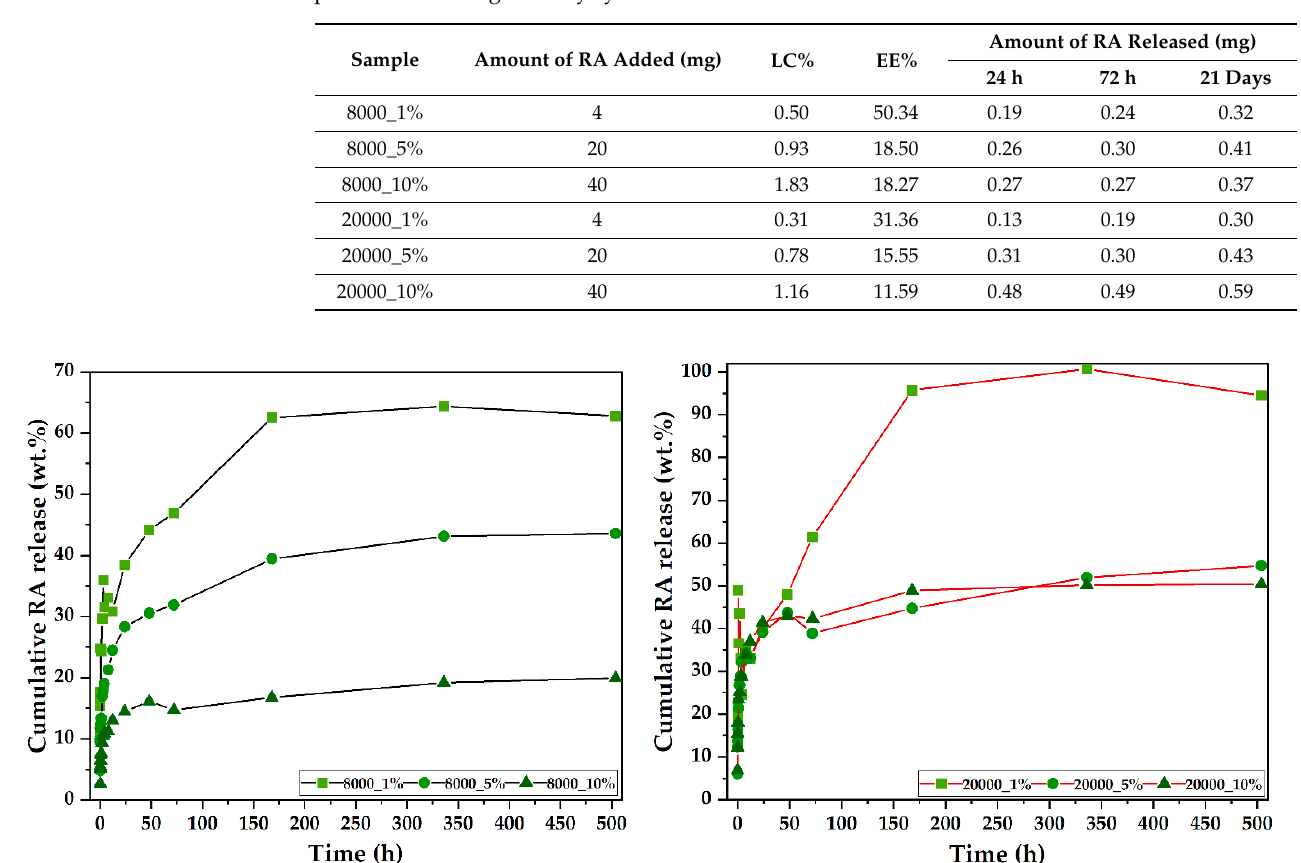
Figure 6. Hydrodynamic diameter ( a ) and zeta potential ( b ) values for the two types of magnetite microspheres, both pristine and RA-loaded (values are expressed as mean ± standard deviation). Table 3. The amount of RA added, the LC% and EE%, and the amount of RA released at specific time points for the drug delivery systems.